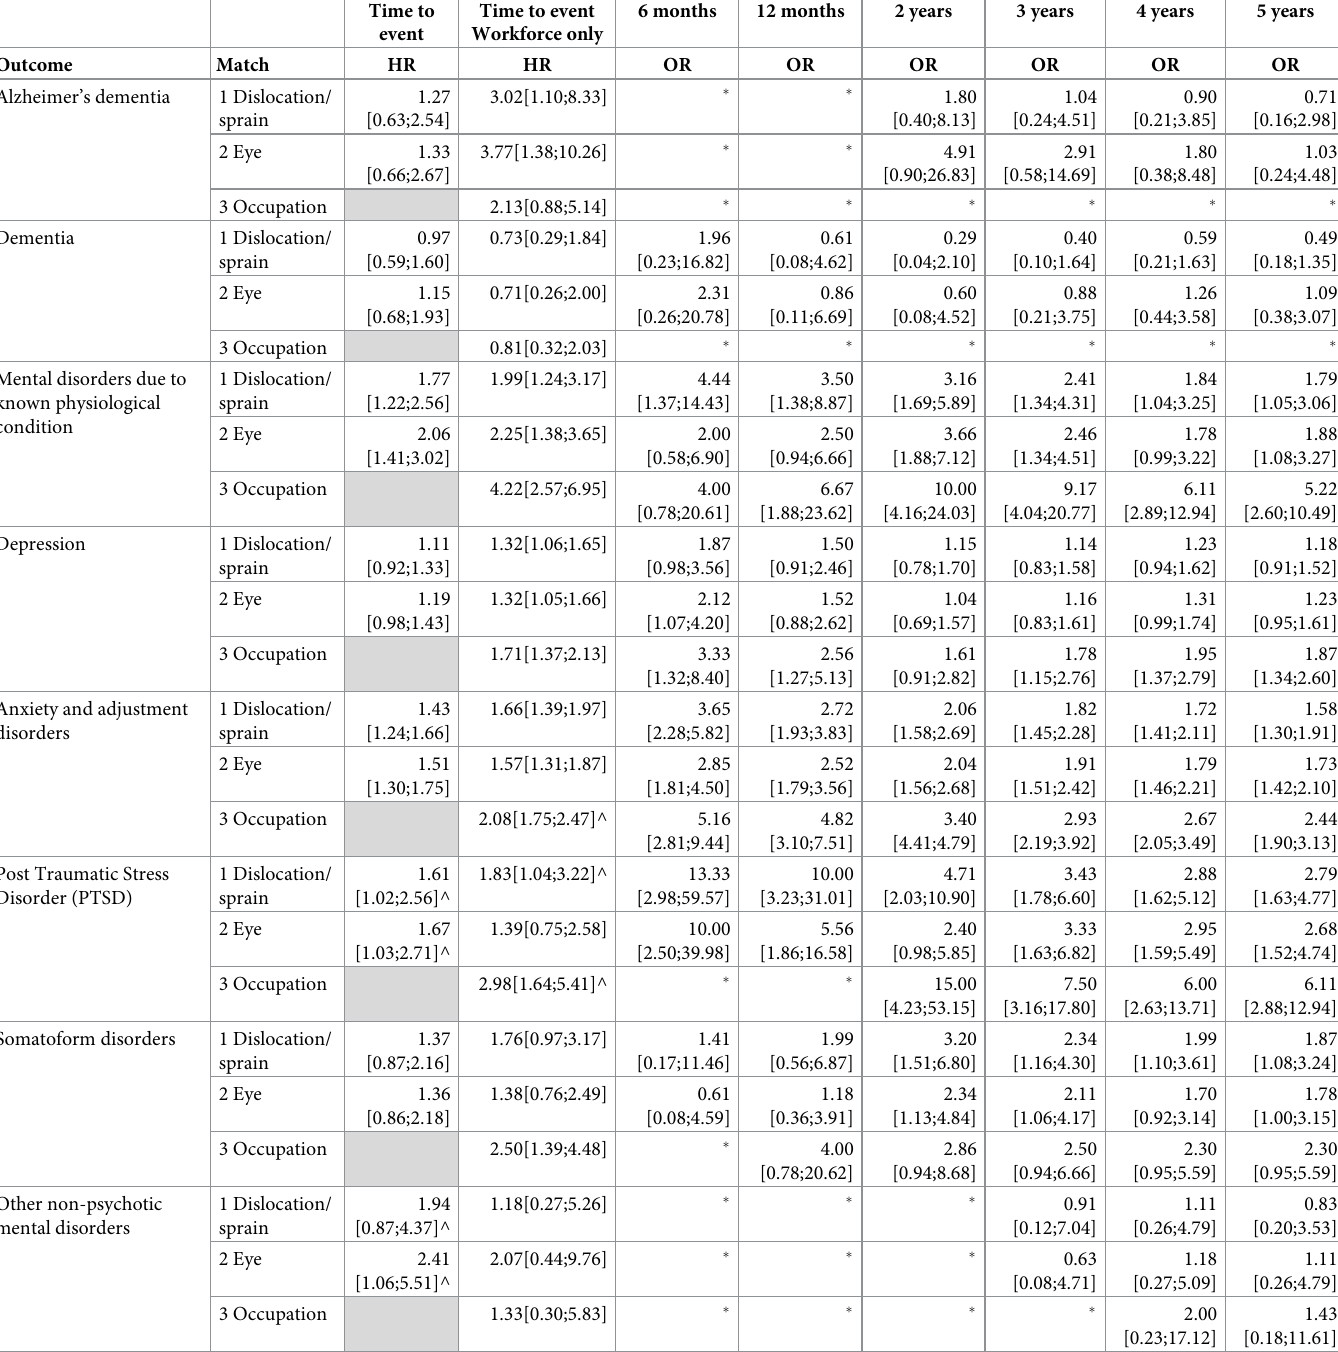
Table 2. Associations between electrical injuries and outcomes over the whole study and in intervals (electrical injuries matched with dislocation/sprain injured, eye injured and occupation